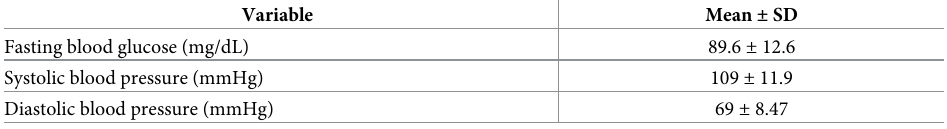
Table 2. Blood pressure and blood glucose of pregnant women in selected primary health center in Jakarta (n = 174). Variable